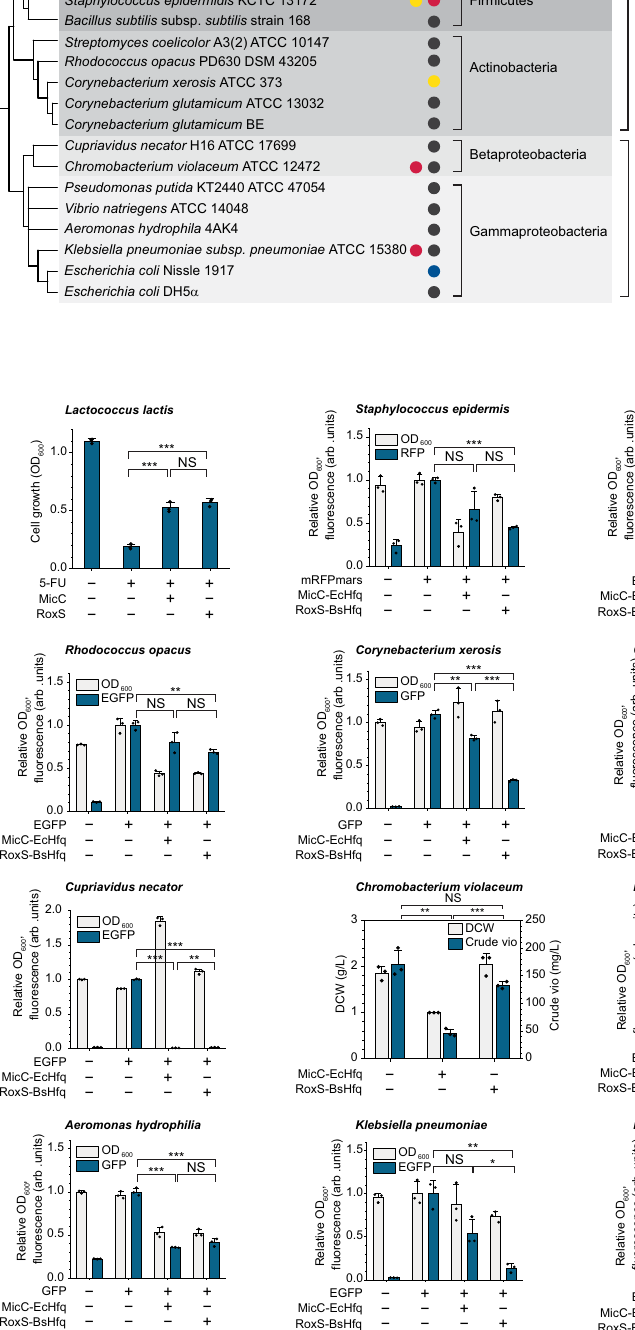
Fig. 2 | Knockdown of target genes in different Gram-negative and Gram- positive bacteria. a Phylogenetic tree of the Gram-negative and Gram-positive bacterial species tested for gene knockdown by the BHR-sRNA system. The phy- logenetic tree was generated using phyloT (https://phylot.biobyte.de/) and visua- lizedwithiTOL 54 . b Knockdownoftargetgenesrelatedtodistinctivephenotypesor genes encoding fl uorescence reporters EGFP, GFP, or mRFPmars in various bac- teria.Thegraphcorrespondingto C.glutamicum ATCC13032wasrearrangedfrom the datainFig. 1d. Crudevio, crude violacein (violaceinand deoxyviolacein);DCW, dry cell weight; * P <0.017, ** P <0.0033, *** P <0.00033, determined by two-tailed